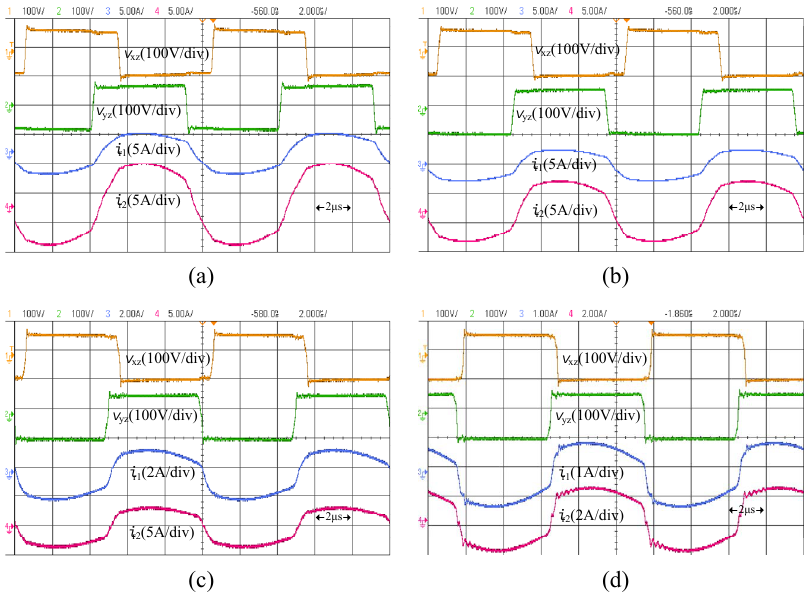
Figure 13. Experimental mid-point voltages v xz , v yz and current results i r 1 , i r 2 at different power levels: ( a ) 200 W, ( b ) 150 W, ( c ) 100 W, and ( d ) 50